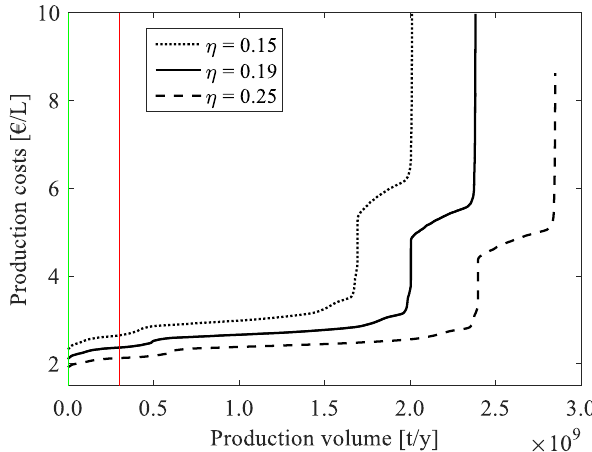
Figure A5. The cost-supply curve of solar thermochemical jet fuel for Southern Africa (South Africa, Botswana, Namibia, Angola) with current national jet fuel demand [93] ( green line ) and world jet fuel demand [91] ( red line ).